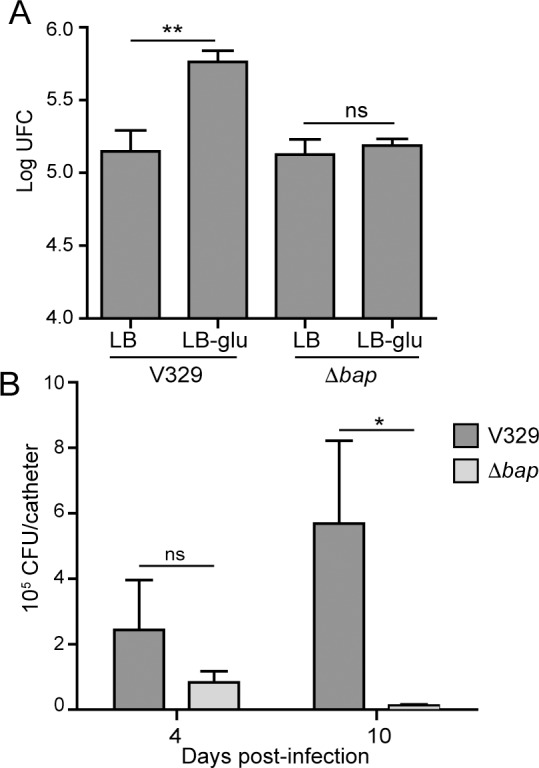
Biological relevance of Bap amyloids.A) Effect of Bap fibers in S. aureus adhesion to epithelial cells. Adhesion of S. aureus V329 wild type and Δbap mutant to the mammary gland epithelial cells MAC-T. Bacterial adhesion was determined after 1 hour of infection. Data represent the means from three independent experiments (**, P<0.01). B) In vivo biofilm formation of S. aureus V329 wild type and Δbap mutant using a catheter infection model. Catheters were infected with equal numbers of the strains, and bacteria were recovered from implanted catheters and counted after 4 or 10 days post-infection. Asterisks indicate significant differences P<0.05. ns, no significant differences. Statistical analysis was performed using the Mann–Whitney test.